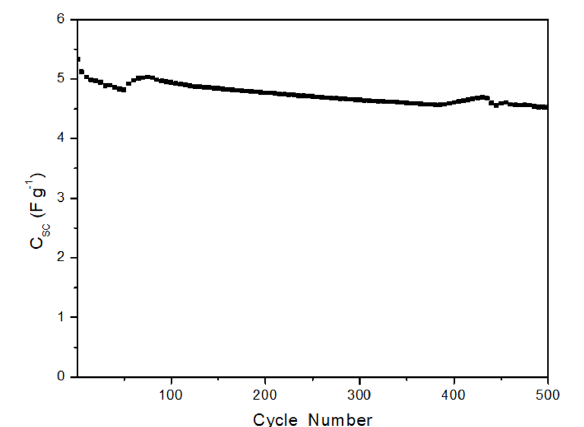
) variation for s c